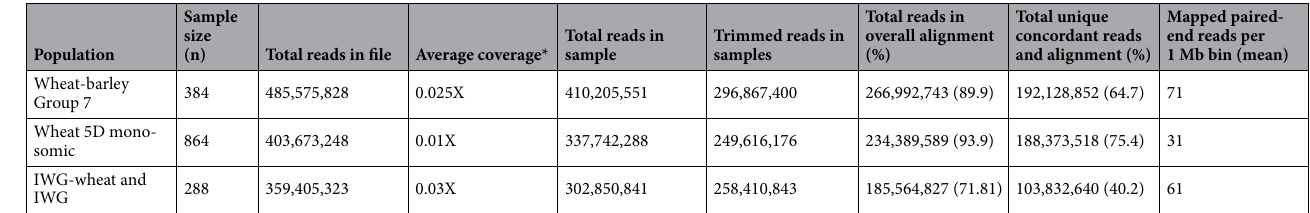
Table 1. Different skim-seq populations, their genome coverage and related information. *Average genome coverage per sample computed as (read count x read length (× 2))/(Genome size x n), where read length = 150 bp. Wheat genome size = 15 Gb. Intermediate wheat grass genome size = 12